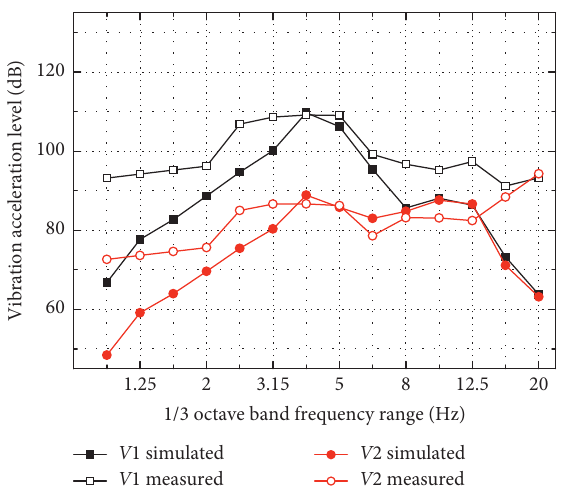
V 1 simulated V 1 measured Figure 14: Comparisons of the simulated VALs with measured ones.